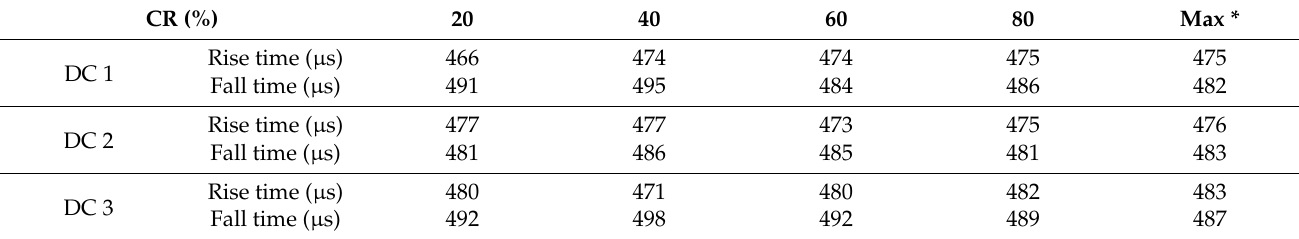
Figure 10. The variation of CRs against the response times for three DCs to switch ( a ) the E 21, ( b ) the E 12 and ( c ) the E 11 modes. Table 3. Response times for three DCs.